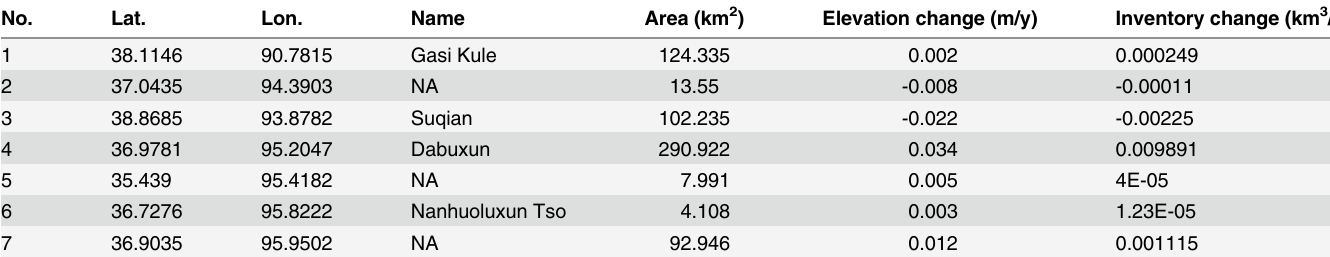
Table 1. Locations of lakes and changes in their water levels and inventory (NA: lake names are not available). No. Lat. Lon.